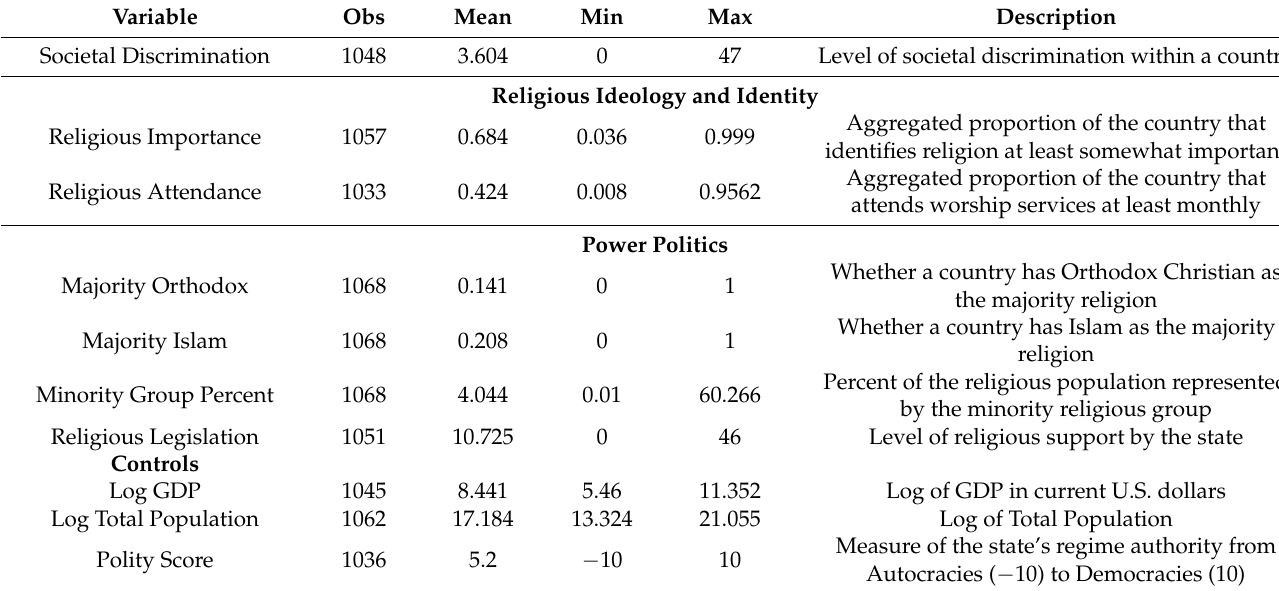
Table 1. Summary statistics and